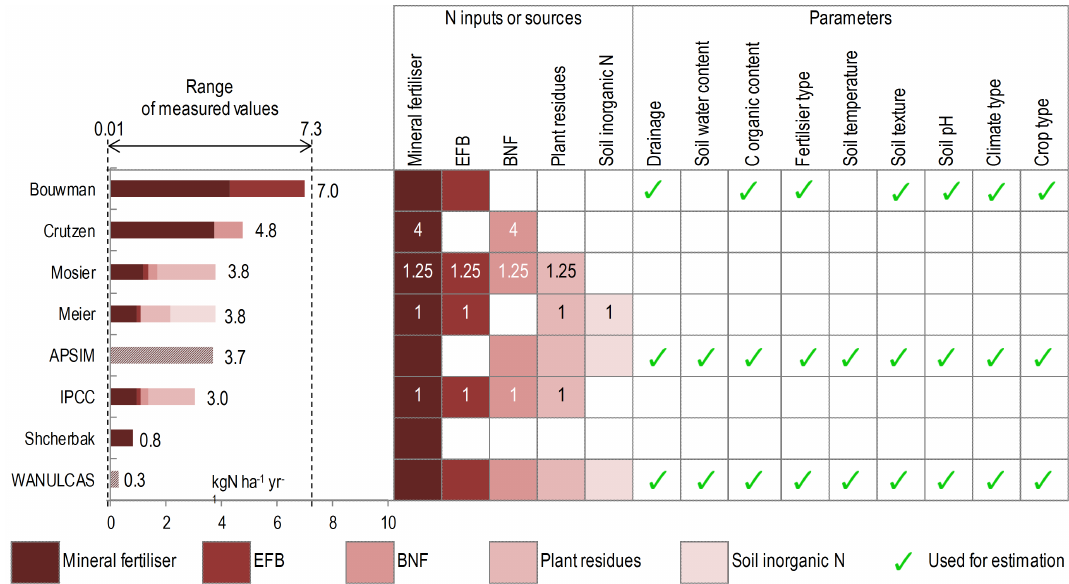
Figure 7. Comparison of annual average losses through N 2 O emissions, estimated by eight sub-models. The average estimate was 3.4kg Nha − 1 yr − 1 , ranging from 0.3 to 7kg Nha − 1 yr. − 1 . For APSIM, all sources are considered in one calculation. Measured values are from Pardon et al. (2016). The table shows the N inputs and parameters used by the sub-models, and emission factors for linear relation- ships. Emission factors are in % of N inputs. BNF: biological N fixation; EFB: empty fruit bunches, i.e. organic fertiliser.